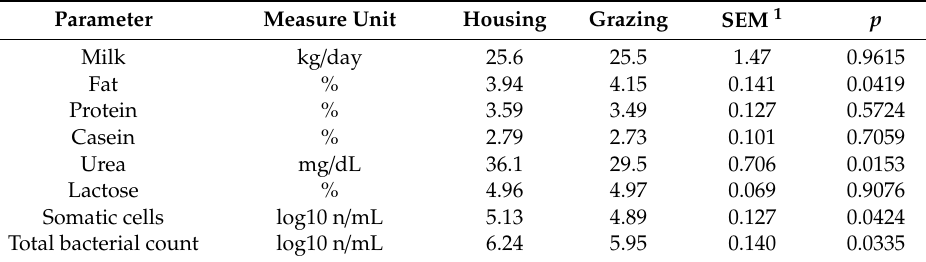
Table 4. E ff ect of feeding system on milk production. Parameter Measure Unit Housing Grazing